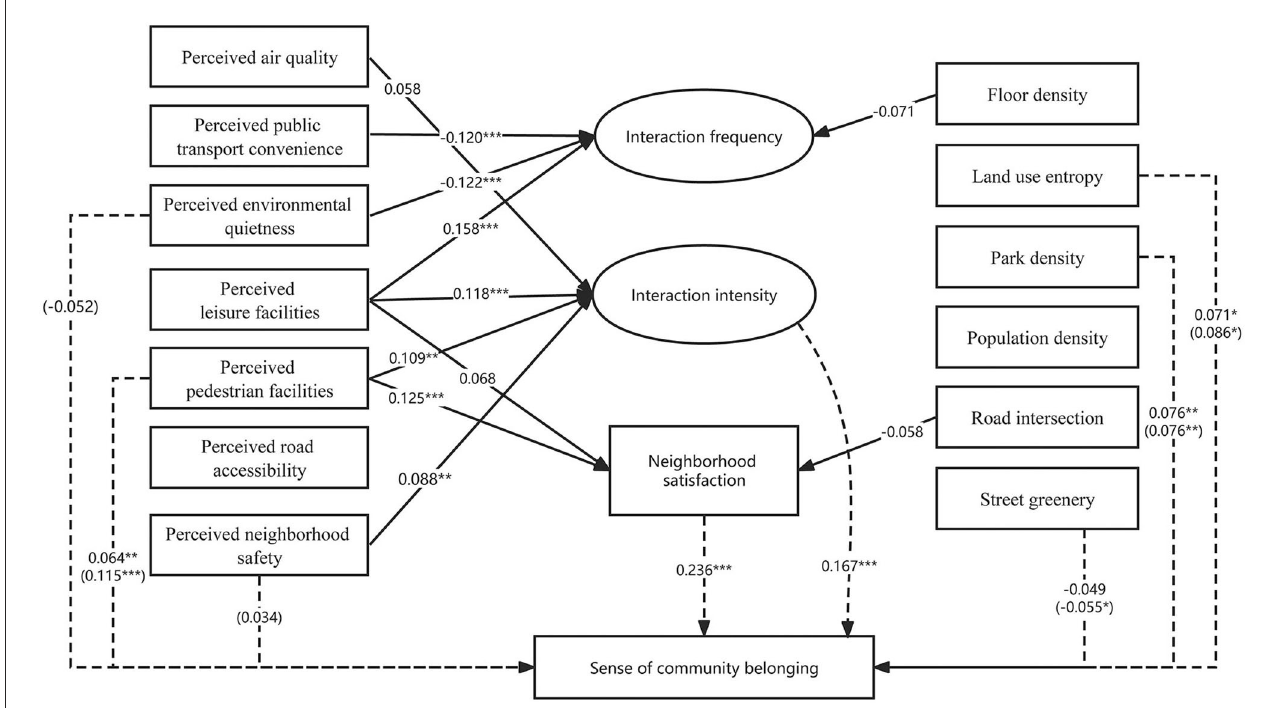
FIGURE3 SEM analysis of the relationship between the built environment and SCB. (1) All the paths shown are significant at the 0.20 level ( P < 0.20). (2) The dashed line shows the direct effect of variables to SCB, and values in parentheses represent total effects (the absence of a value before the parentheses means that the variable has no direct effect on SCB at the 0.20 level). Solid lines show the effect of exogenous variables on interaction behavior and community satisfaction. (3) * 0.05 ≤ P < 0.1; ** 0.01 ≤ P < 0.05; *** P <